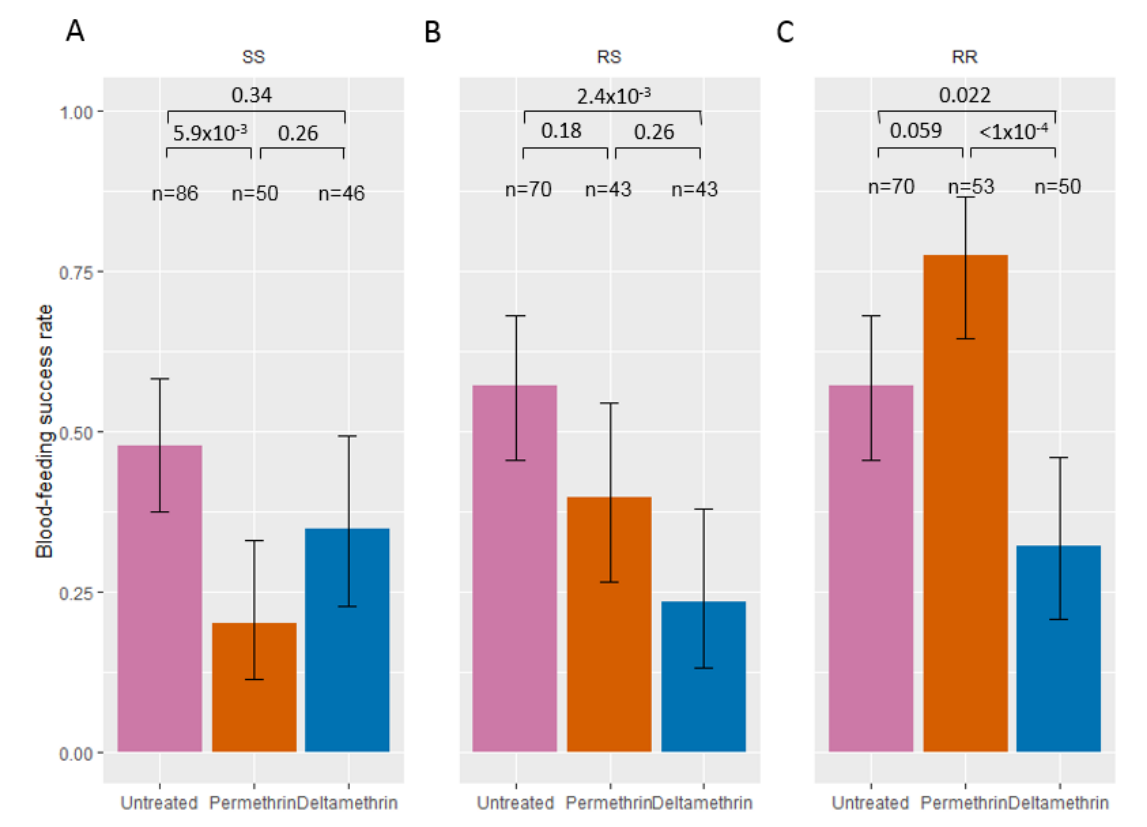
Figure 3. Feeding success after exposure to insecticides of Anopheles gambiae females of each kdr genotype. Feeding success of SS, RS, and RR (panels A, B and C, respectively) genotypes when exposed to untreated, permethrin-treated (Olyset) and deltamethrin-treated (PermaNet) nettings are shown with 95% binomial confidence intervals of the proportions (error bars). Numbers n of mosquitoes exposed to each treatment and for each genotype are indicated. P-values according to Tukey’s test after binomial mixed-effect model is